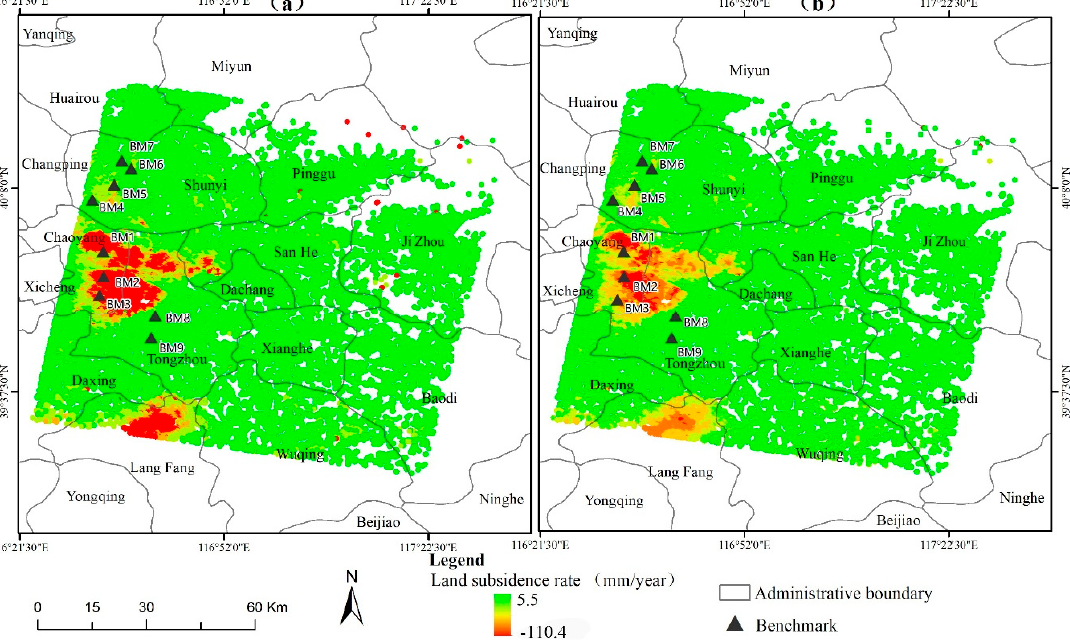
Figure 12. Comparison of land subsidence rate calculated for the study area for the period between 2014 and 2016, using ( a ) PS-InSAR and ( b ) PS-InSAR + RELAX. Positive land subsidence rates (cold colors) represent the motion of the ground toward the satellite, and negative land subsidence rates (warm colors) represent the motion away from the